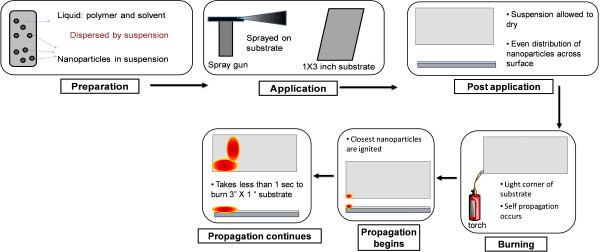
Represents the schematic of the proposed process for ultra-rapid removal of biofilms, which involves spray coating the nanoparticles in suspension onto the substrate containing biofilm, followed by burning the entire surface of the substrate by initiating the ignition of one of its corners.